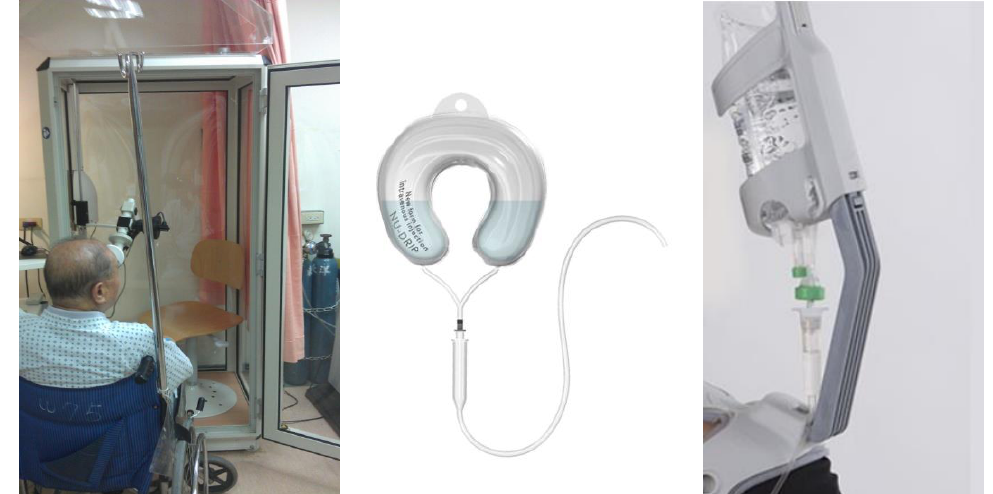
Figure 4. Examples of drip frames: a drip frame attached to a wheelchair (left); a new U-shape form for intravenous infection [12] (middle); a shoulder-mounted drip frame, EZPole, designed by Mobiu Corporation Ltd [16] (right).